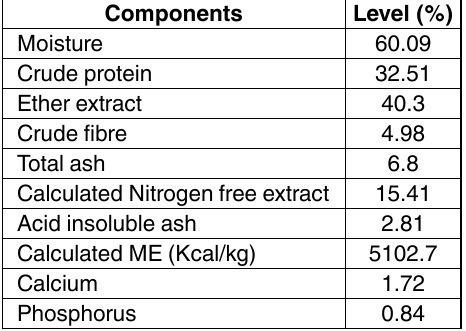
Table 1. Chemical compositions of